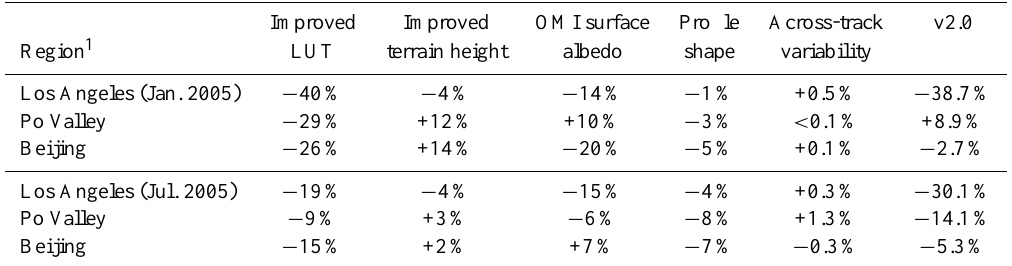
Table 3. Summary of individual changes in local (1 ◦ × 1 ◦ ) tropospheric NO 2 retrievals relative to DOMINO v1.02. v2.0 refers to the combined effect of all individual